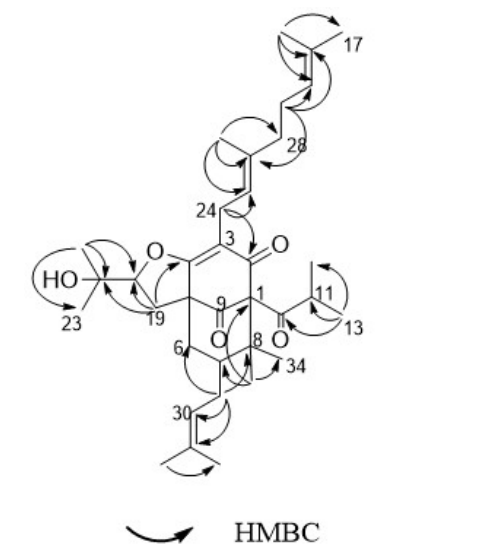
Figure 5. Selected key HMBC and ROESY correlations of 2 .